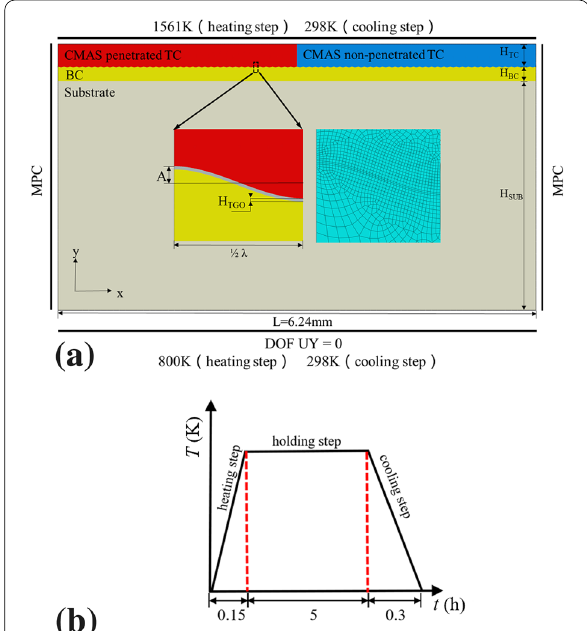
Figure 2 ( a ) Two-dimensional multi-period global model of APS TBCs with CMAS non-uniform penetration, ( b ) thermal boundary conditions of